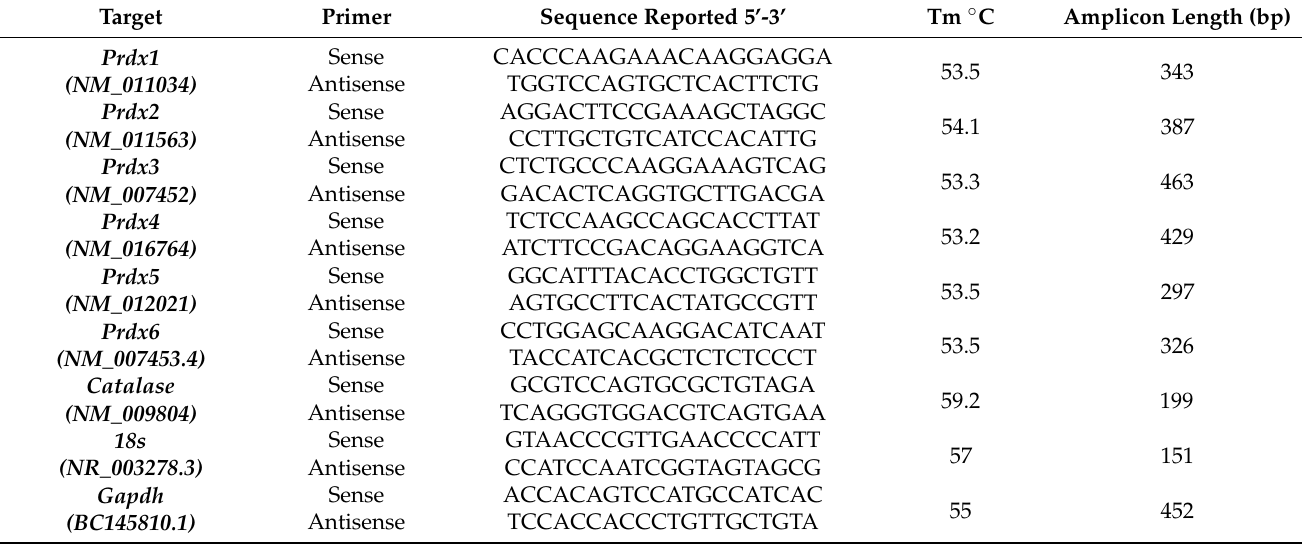
Table 2. Primer sequence for reverse transcription